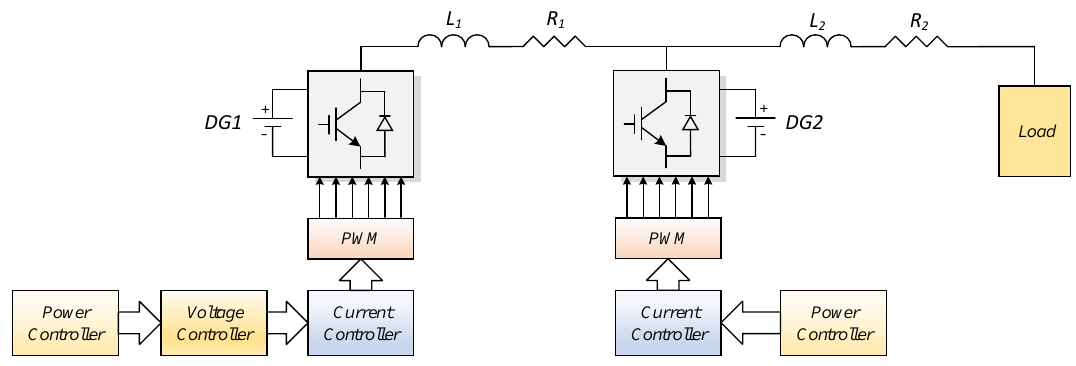
Figure 1. Structure of inverter based distributed generation in MG system.